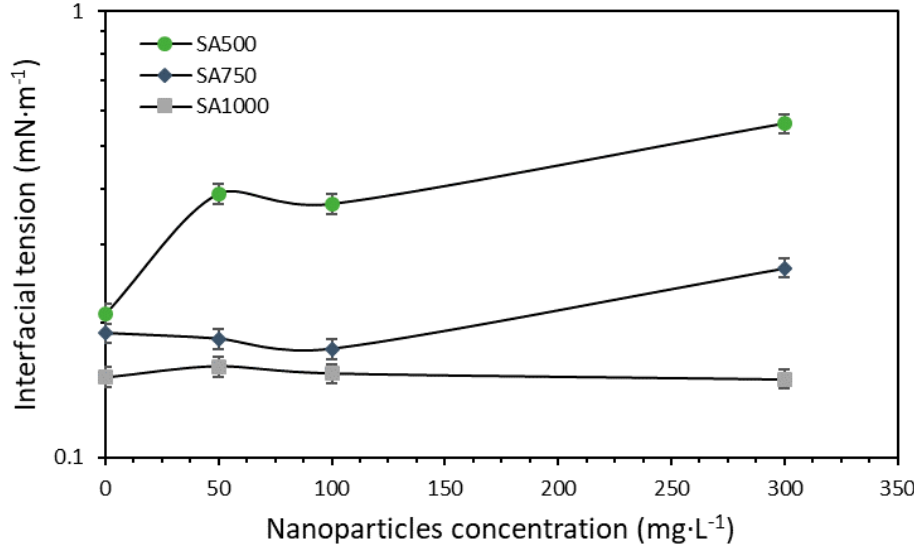
Figure 9. Interfacial tension measurements in constant brine TDS of 0.75%. The tests were conducted at 50 °C with SA surfactant and CNA nanoparticle concentrations from 500 to 1000 mg·L − 1 and from 0 to 300 mg·L − 1 , respectively. The symbols represent the experimental data, and error bars represent standard deviation.